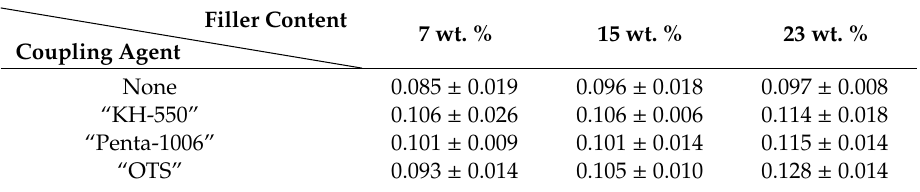
Table 5. The friction coe ffi cients of the UHMWPE-based composites with various wollastonite contents; the “ball-on-disk”